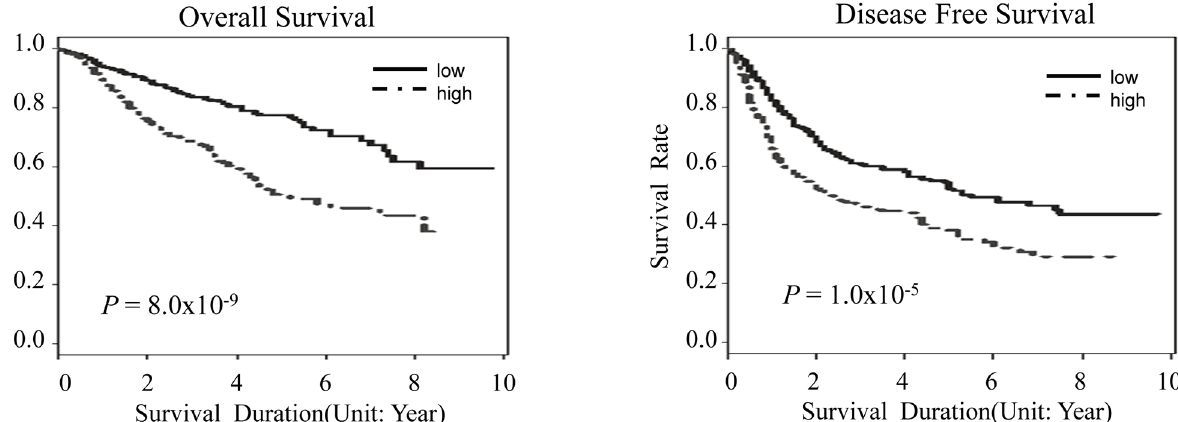
Fig 1. Kaplan-Meier plots of overall survival and disease-free survival according to risk groups. P values in the multivariate Cox proportional hazard